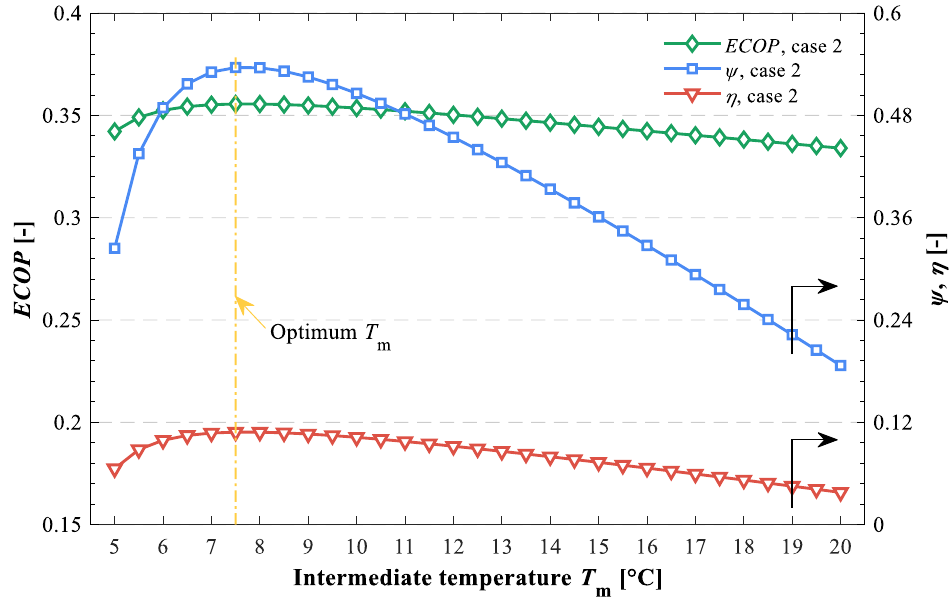
Figure 11. Effect of intermediate temperature on performance indicators for the layout with a cascade condensation process in case 2.